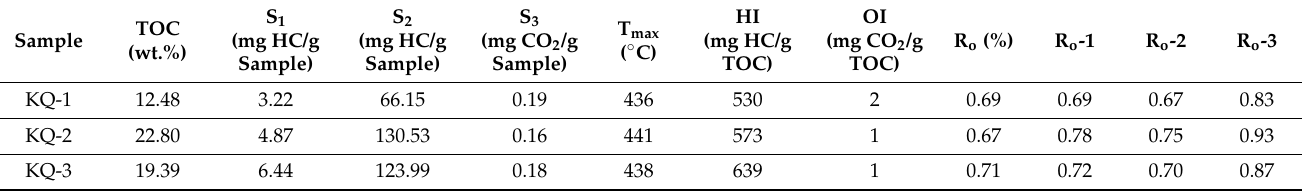
Table 2. Total organic carbon (TOC) content and Rock-Eval pyrolysis results of the studied Chang 7 Member shale